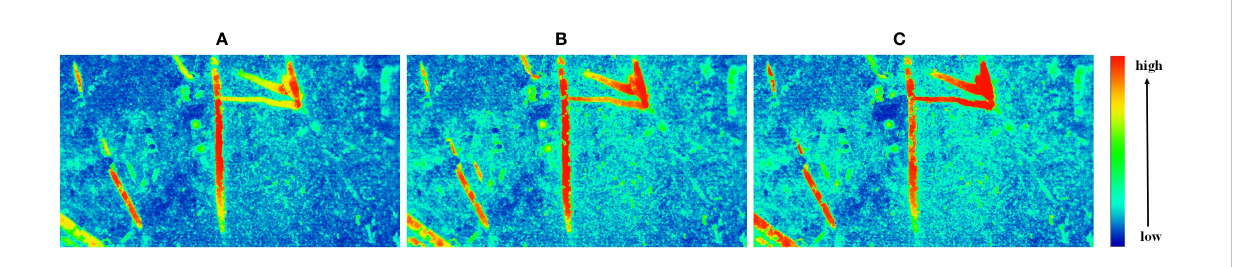
FIGURE 10 Feature extraction visualization. (A) Original network, (B) After replacing the backbone with ResNet, (C) After adding the PSA